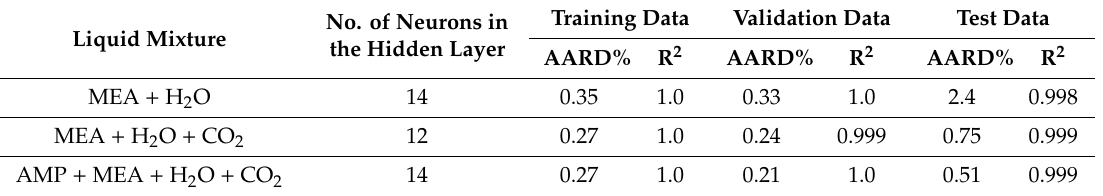
Table 5. Performance of trained ANNs for viscosity.